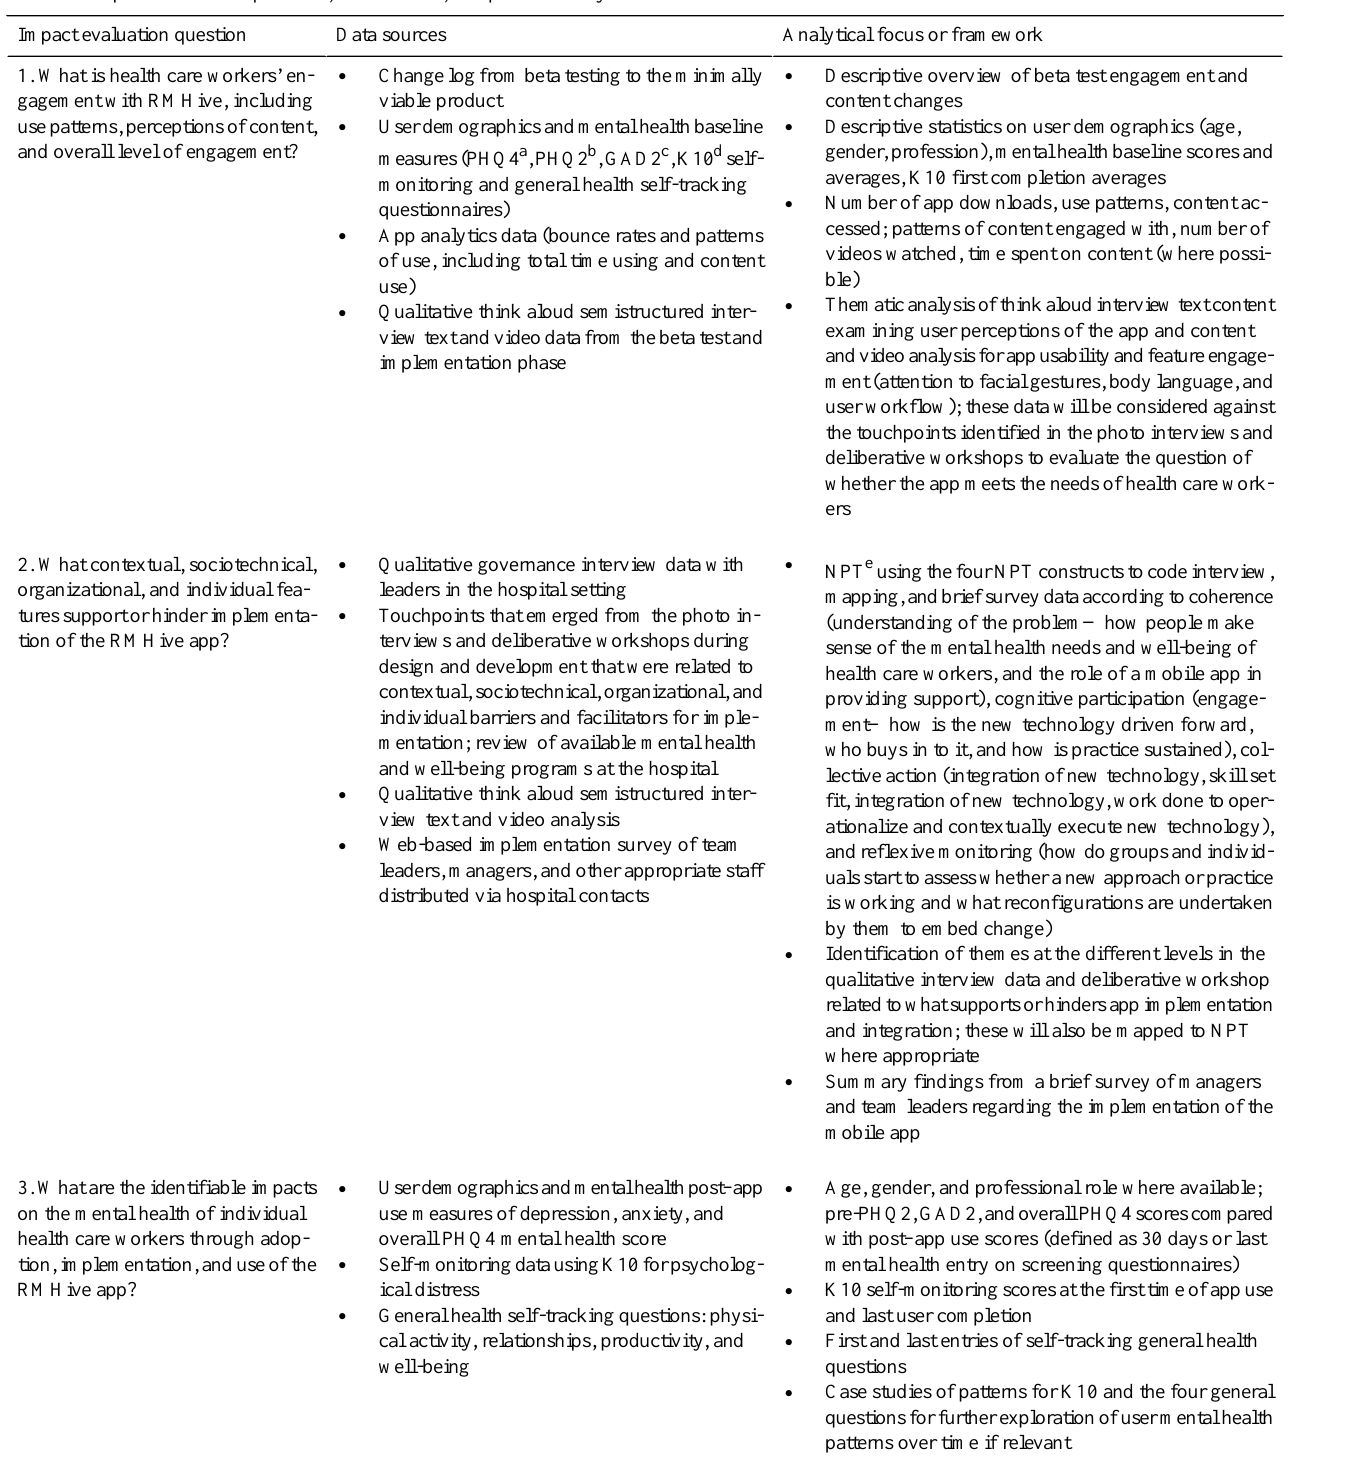
Table 1. Impact evaluation questions, data sources, and planned